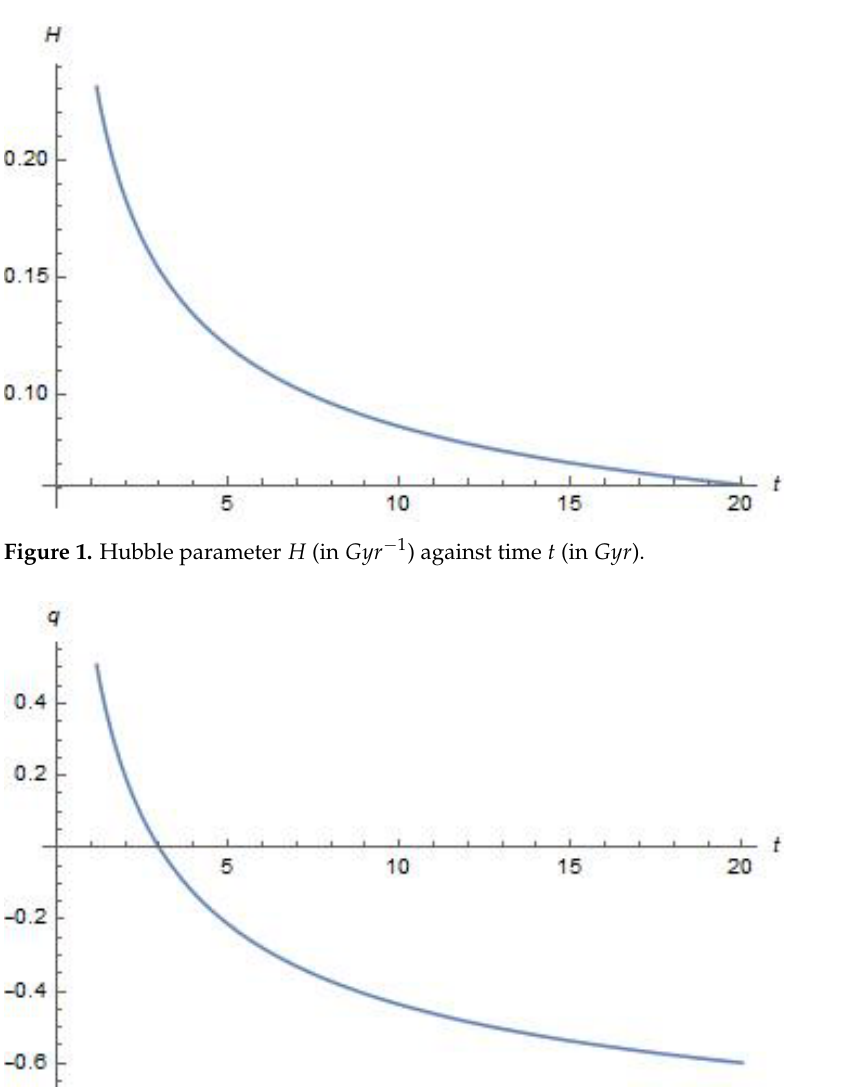
Figure 2. Deceleration parameter q against time t (in Gyr